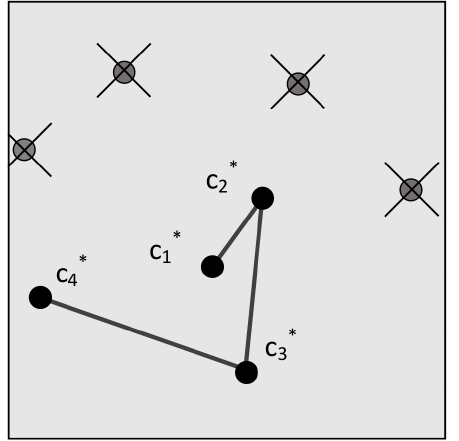
Figure 9. Output of confirmation phase of MPA (reprinted from [42], with permission from